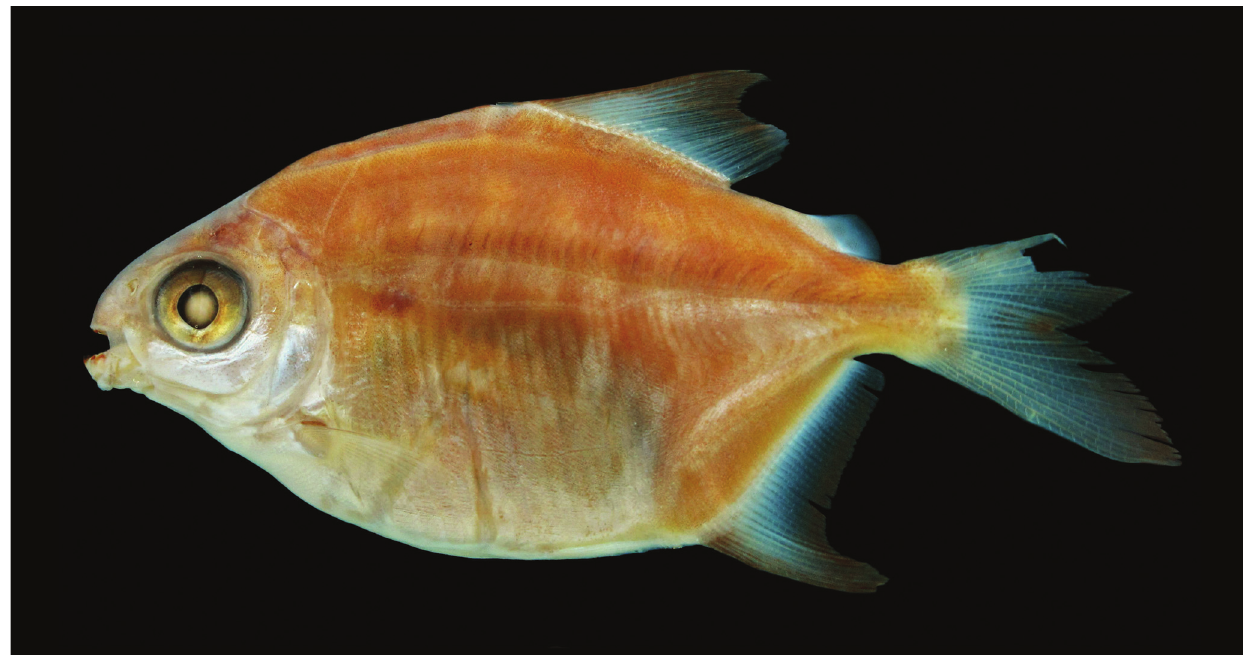
Fig. 3. Tometes camunani , INPA 3637, juvenile, 44.7 mm SL; Brazil, Pará, Oriximiná, rio Trombetas, Cachoeira Porteira.